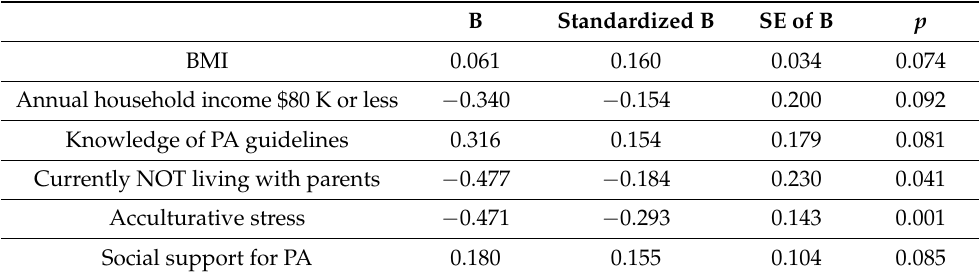
Table 4. Adjusted effects on MVPA Minutes Per Week in the final model (n = 103).